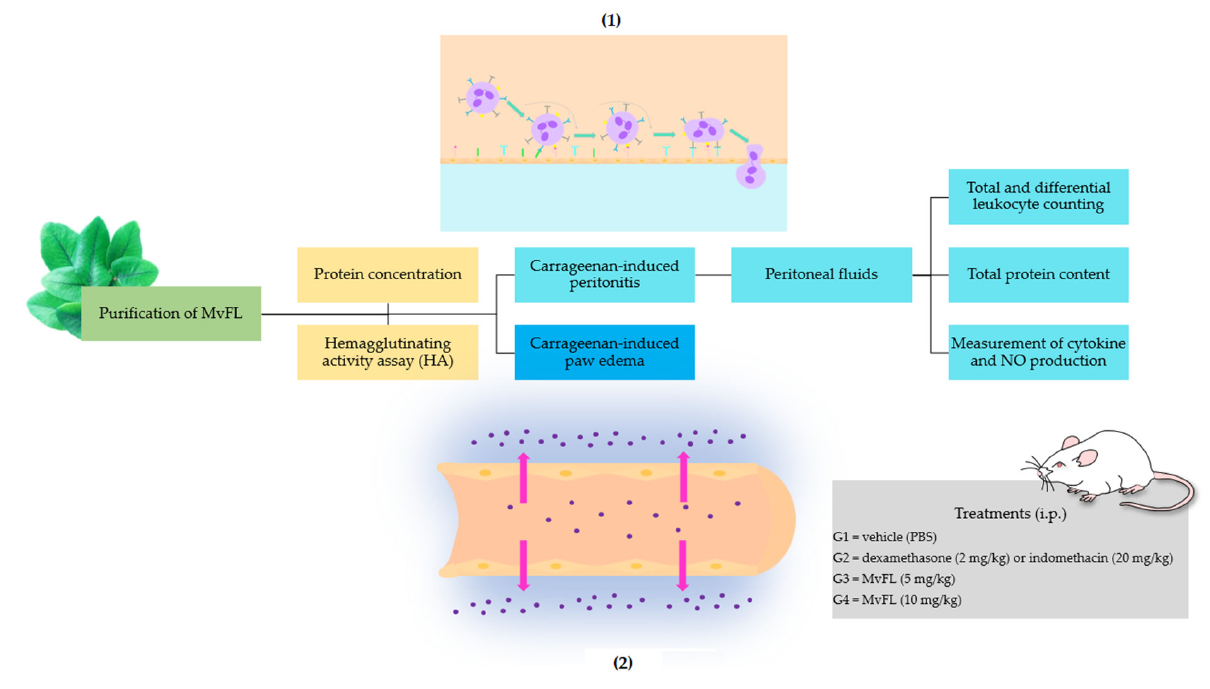
Figure 1. Graphical representation of the study design. The effects of MvFL on inflammatory status in the carrageenan-induced peritonitis and paw edema were investigated in Swiss mice. The animals were pretreated intraperitoneally with MvFL. In the peritonitis assay, the total and differential migration of the leukocytes were evaluated, as well as the total protein, cytokines, and nitric oxide (NO) levels in the peritoneal fluid. The inset 1 schematizes the recruitment of leukocytes to the area of inflammation. In the paw edema assay, the volume of the paw was measured in the early (30 min–2 h) and late (3–4 h) phases of edema formation. The inset 2 shows the edema formation process with extravasation of the plasma proteins followed by movement of the fluid from the intravascular to the interstitial space.